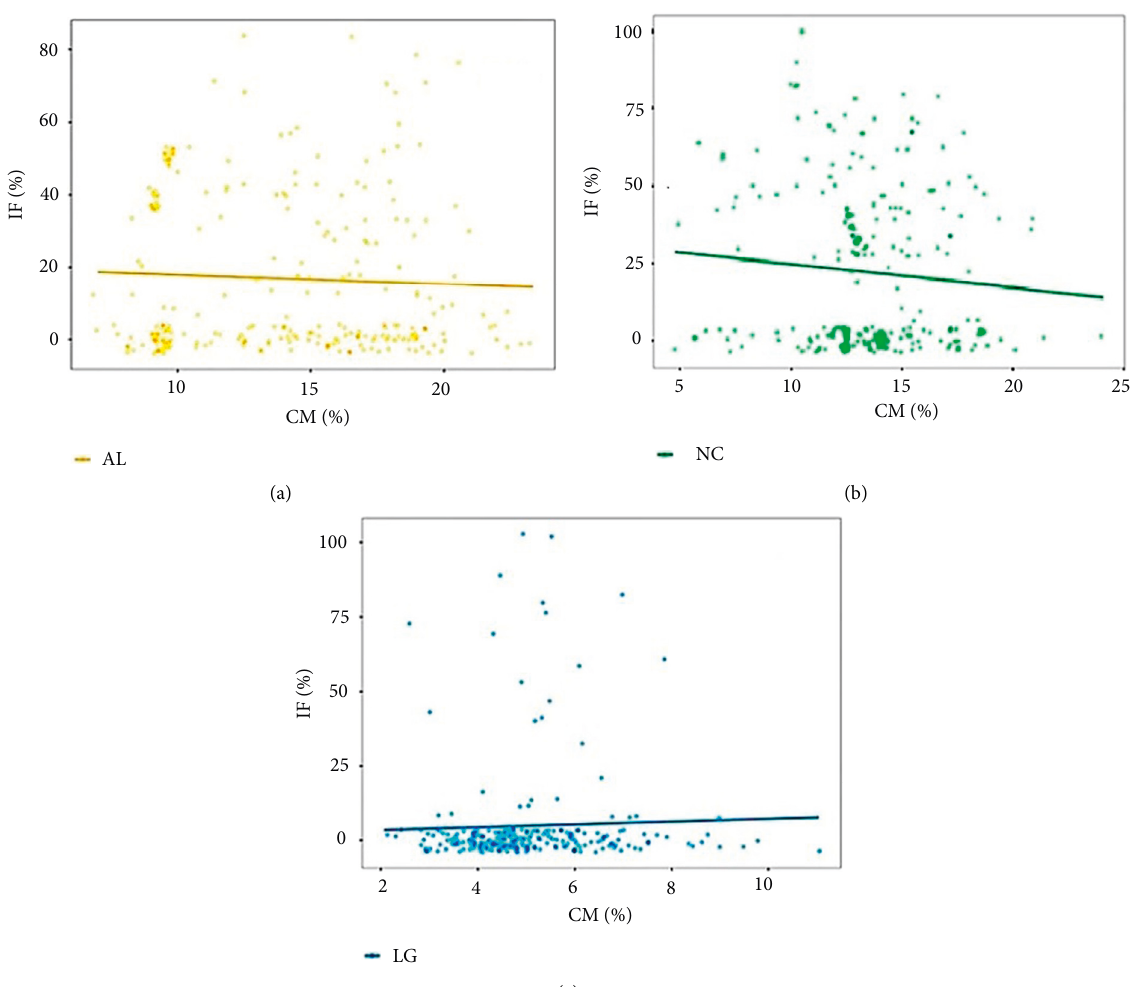
Figure 6: FI for each seed species. (a) A. lechuguilla ; (b) N. cespitifera ; (c) L. graveolens .